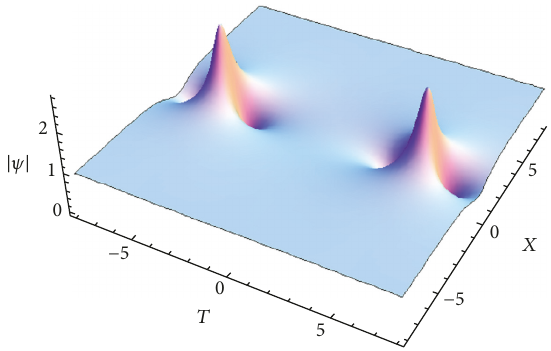
Figure 11: Spatial structure of the module of solution (81) with 𝑘 = 0.6